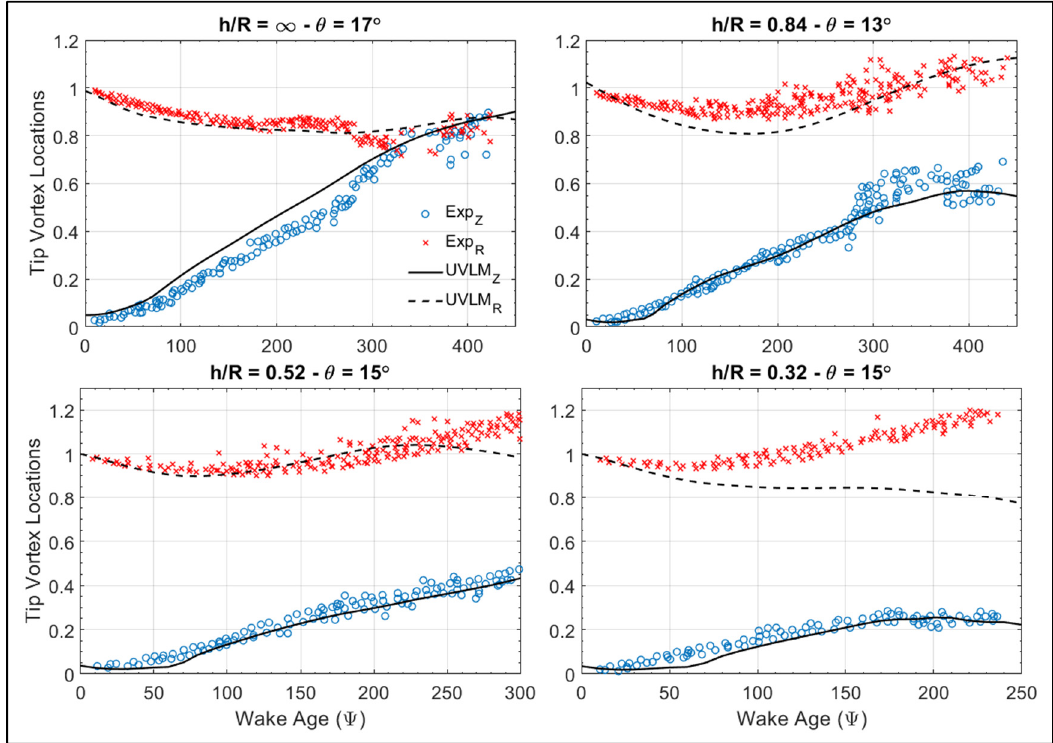
Figure 9. UVLM versus experimental radial and vertical tip vortex positions for the lynx rotor.